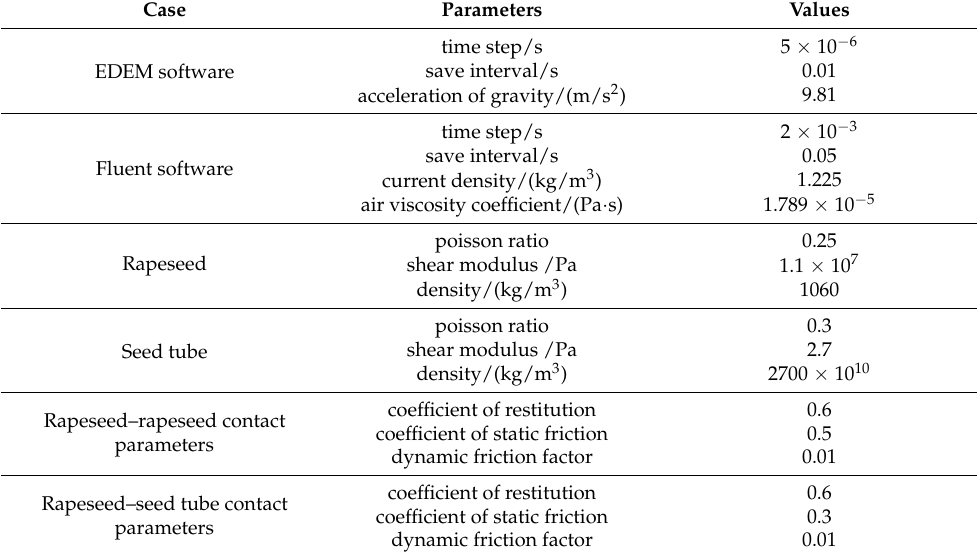
Table 2. Simulation